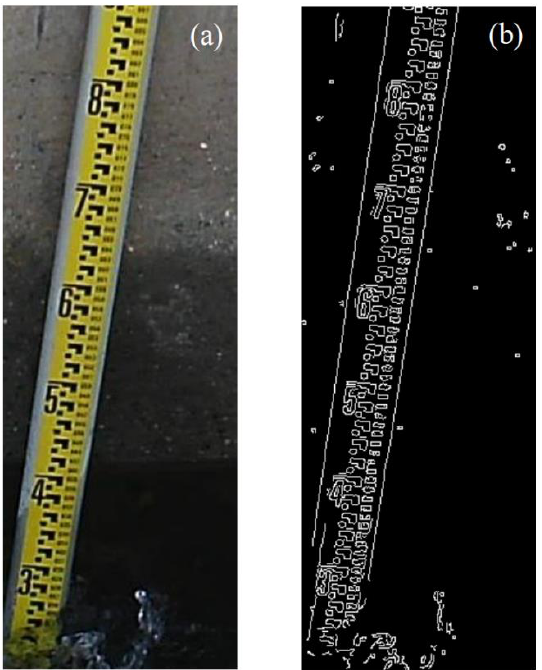
Figure 13. The effect of contour detection and edge detection. ( a ) is obtained from Figure 12 by the size of the area of the detected contour. ( b ) The effect from ( a ) by the edge detection of Canny oper-